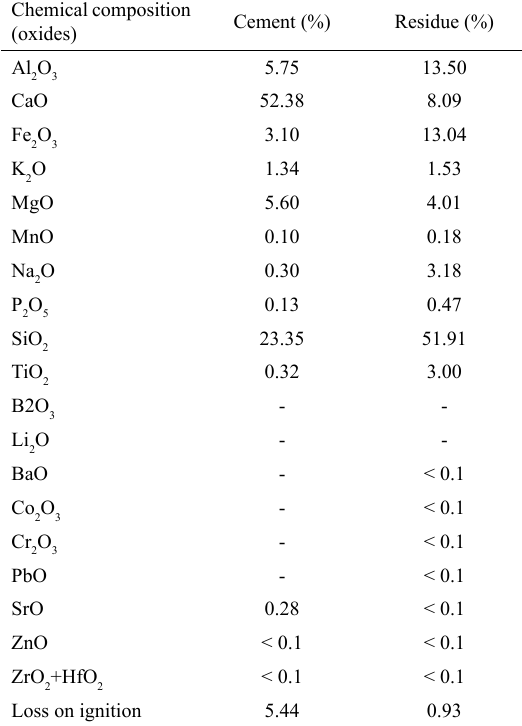
Table 2. Chemical composition (mass percent) by XRF of the filer and